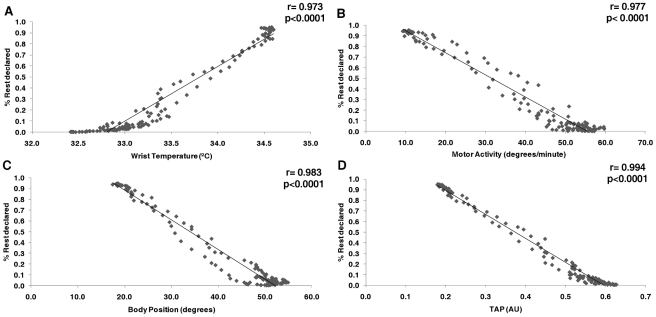
Correlations between every variable with respect to rest declared by subjects.Wrist temperature (A), motor activity (B), body position (C) and TAP (D). Please note correlations coefficients and its probability value on the upper right of every pannel.